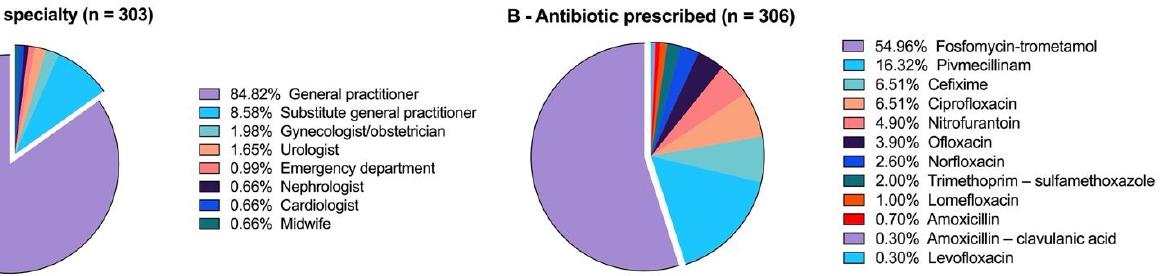
Figure 1. The origin of the prescriber ( A ) and the nature of the antibiotic prescribed ( B ) among the 303 selected prescriptions. In three cases, two antibiotics were prescribed at the same time for the same patient (n = 306).